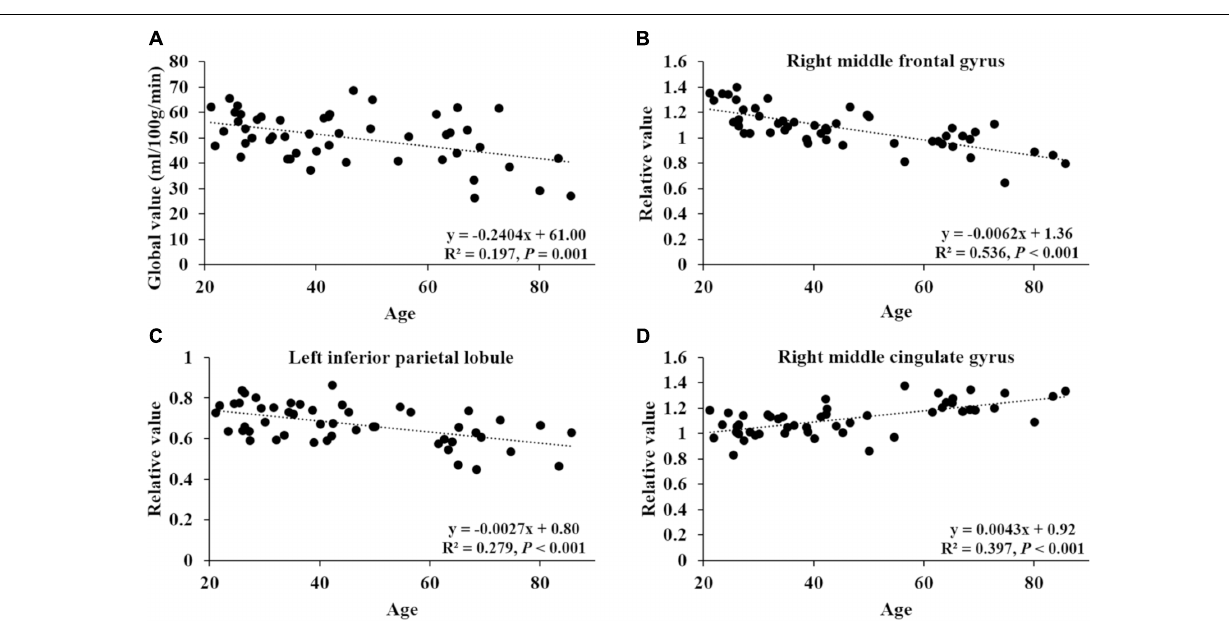
FIGURE 2 | Correlation of age with global CBF value and relative CBF values in three sample regions. (A) The correlation between age and global value from the CBF map. (B–D) The correlations between age and relative values of right middle frontal gyrus (44, 8, 50), left inferior parietal lobule (–58, –52, 42) and right middle cingulate gyrus (15, –14, 46), obtained post hoc within a spherical volume of interest (4 mm